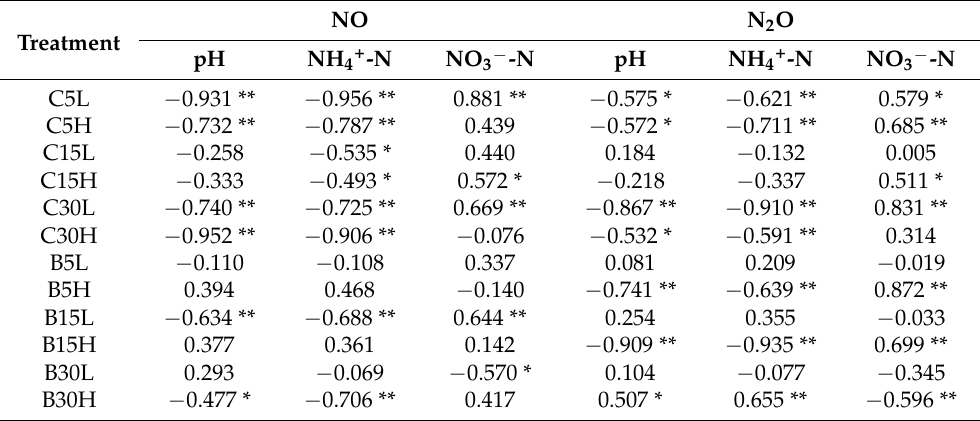
Table 2. Correlations between soil Nitrogen oxide (NO or N 2 O) emissions and soil pH and mineral ni- trogen.